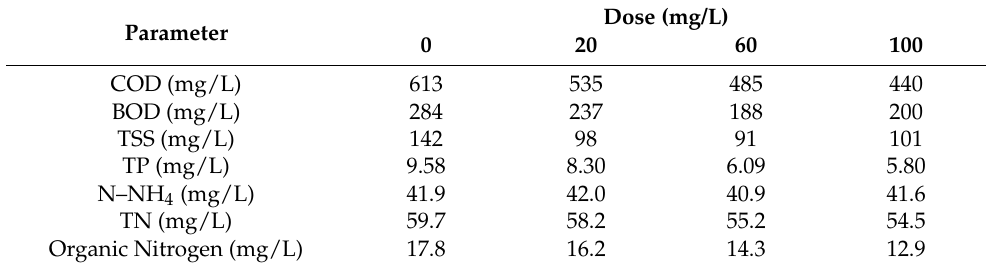
Table 2. Wastewater parameters after CEPT application in laboratory trials.